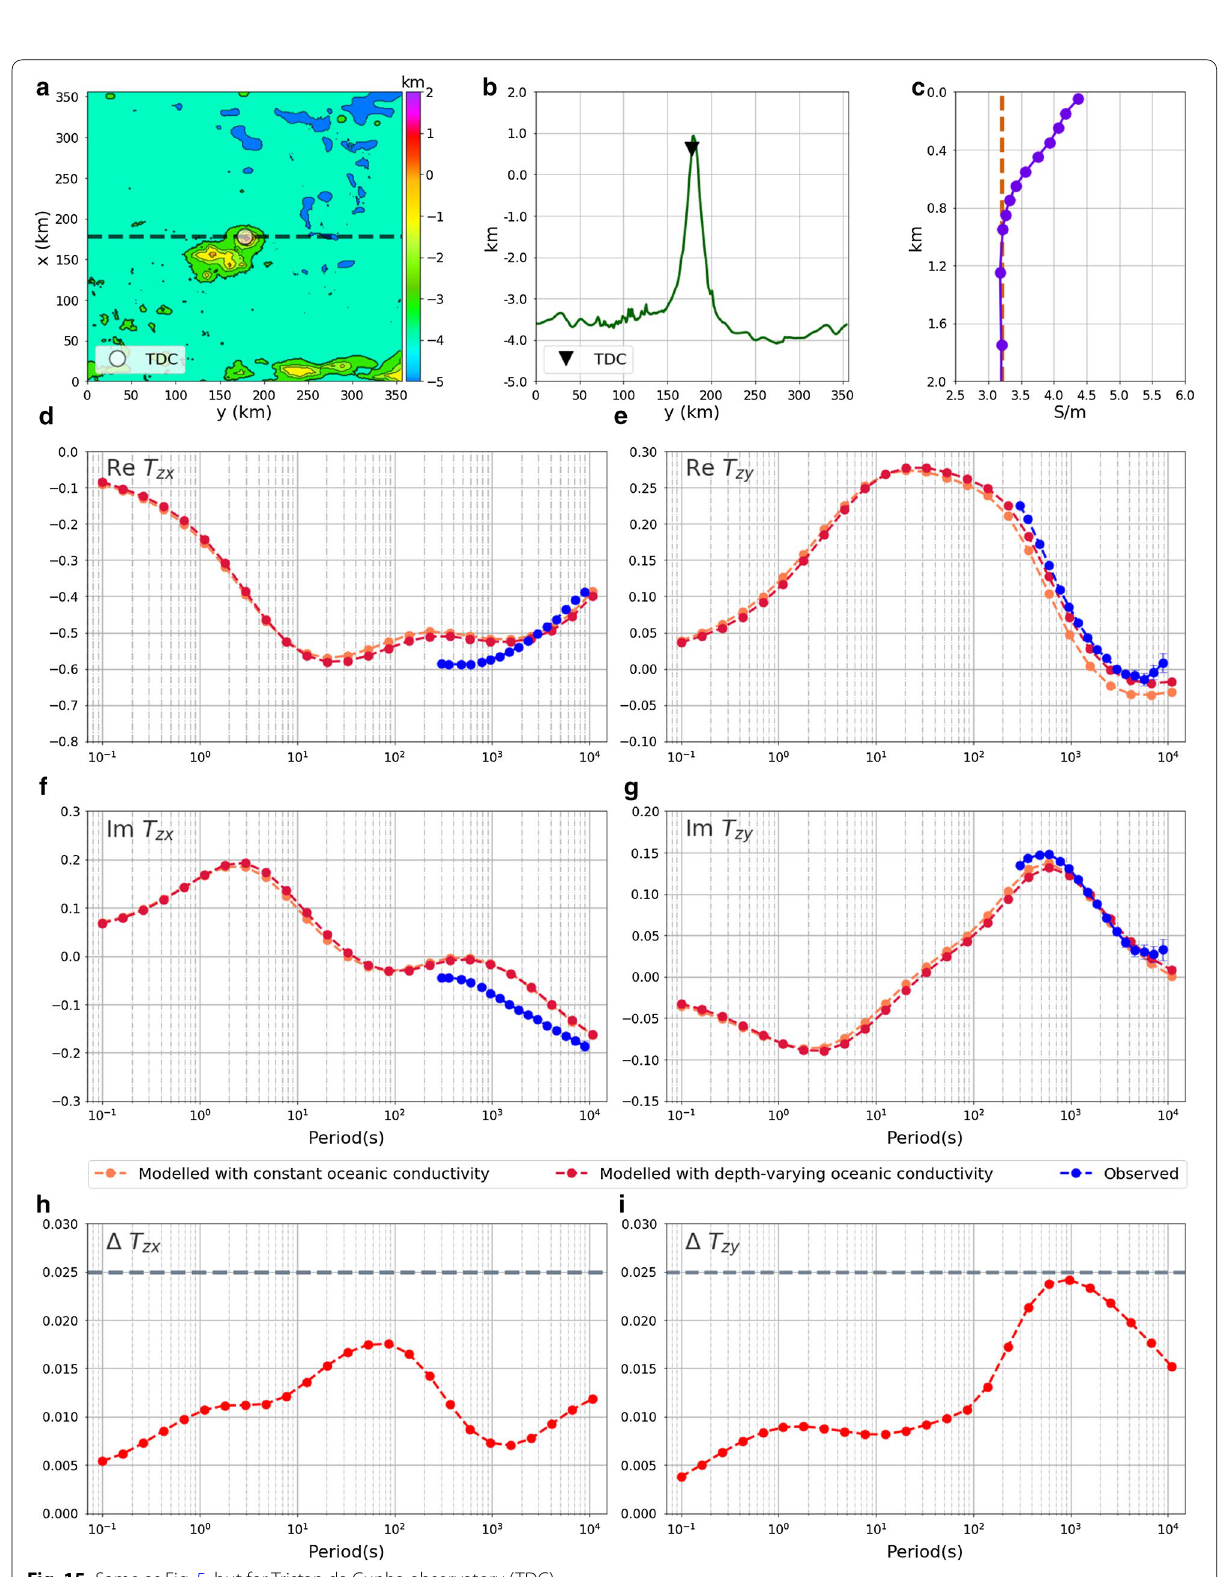
Fig. 15 Same as Fig. 5, but for Tristan da Cunha observatory